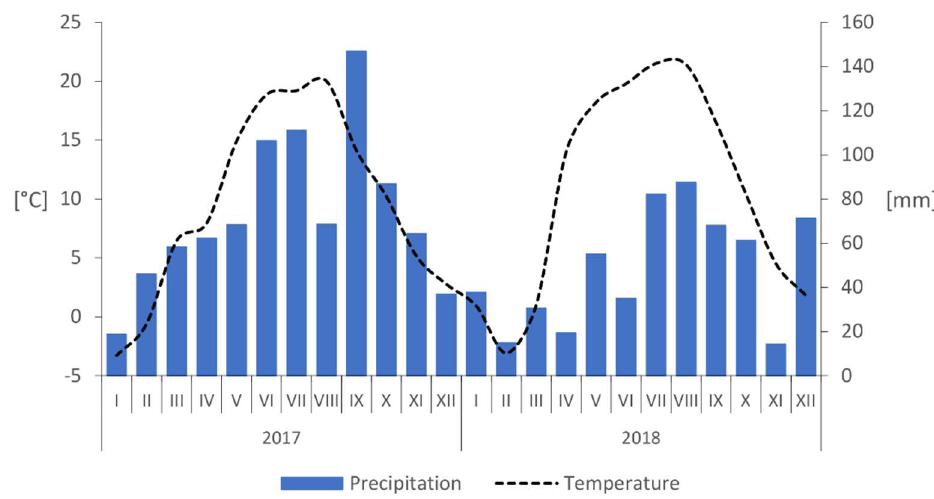
Figure 1. Weather conditions in the ‘Red Jonaprince’ apple orchard during 2017-2018.